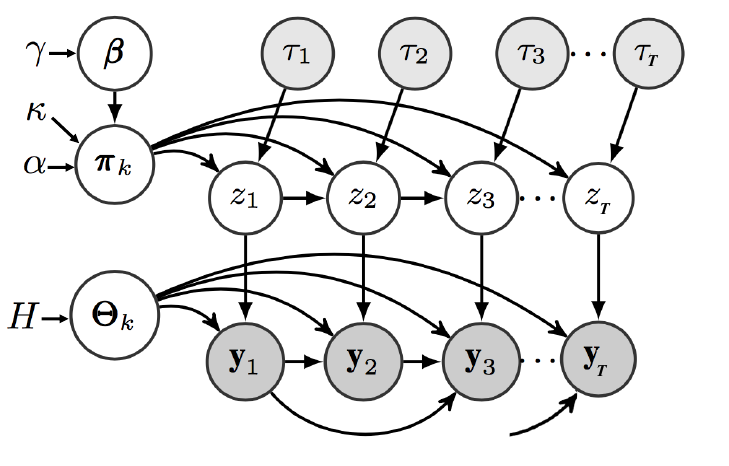
z t t being dependent on the indicator variable which are in t